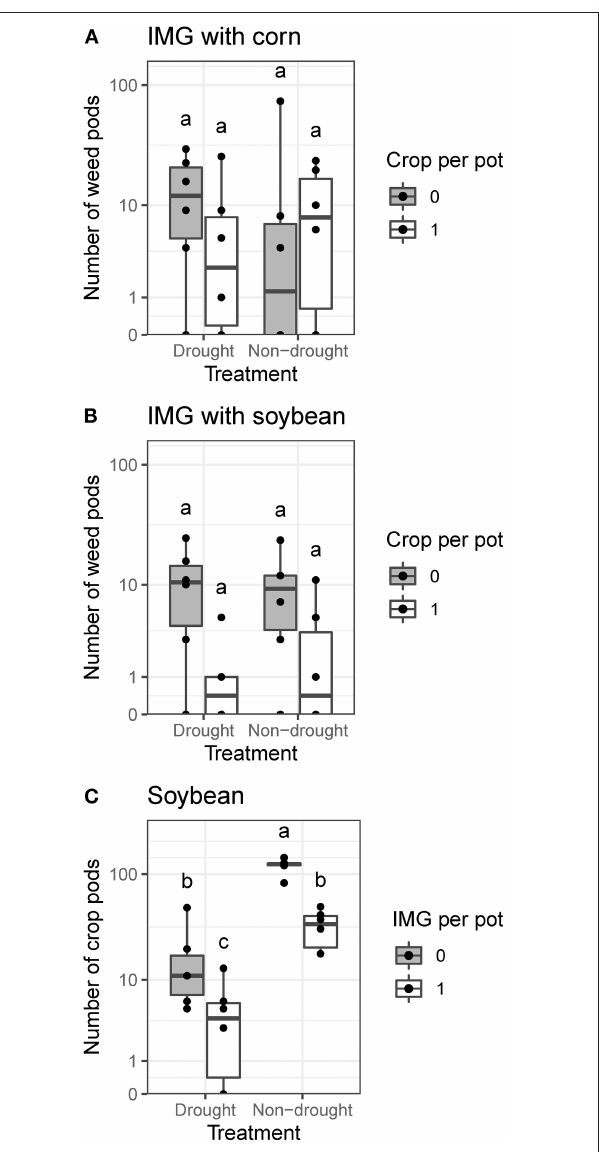
FIGURE 4 | Effects of drought treatment and corn, soybean, or ivyleaf morningglory (IMG) on the number of IMG or soybean pods produced under greenhouse conditions. (A) For IMG pod production, pots with a single IMG plant (0R1W) are compared to pots with one corn plant and one IMG plant (1R1W). (B) For IMG pod production, pots with a single IMG plant (0R1W) are compared to pots with one soybean plant and one IMG plant (1R1W). (C) For soybean pod production, pots with a single soybean plant (1R0W) are compared to pots with one soybean plant and one IMG plant (1R1W). Within species combination, treatments labeled with the same letter are not significantly different according to Tukey’s HSD test ( α =